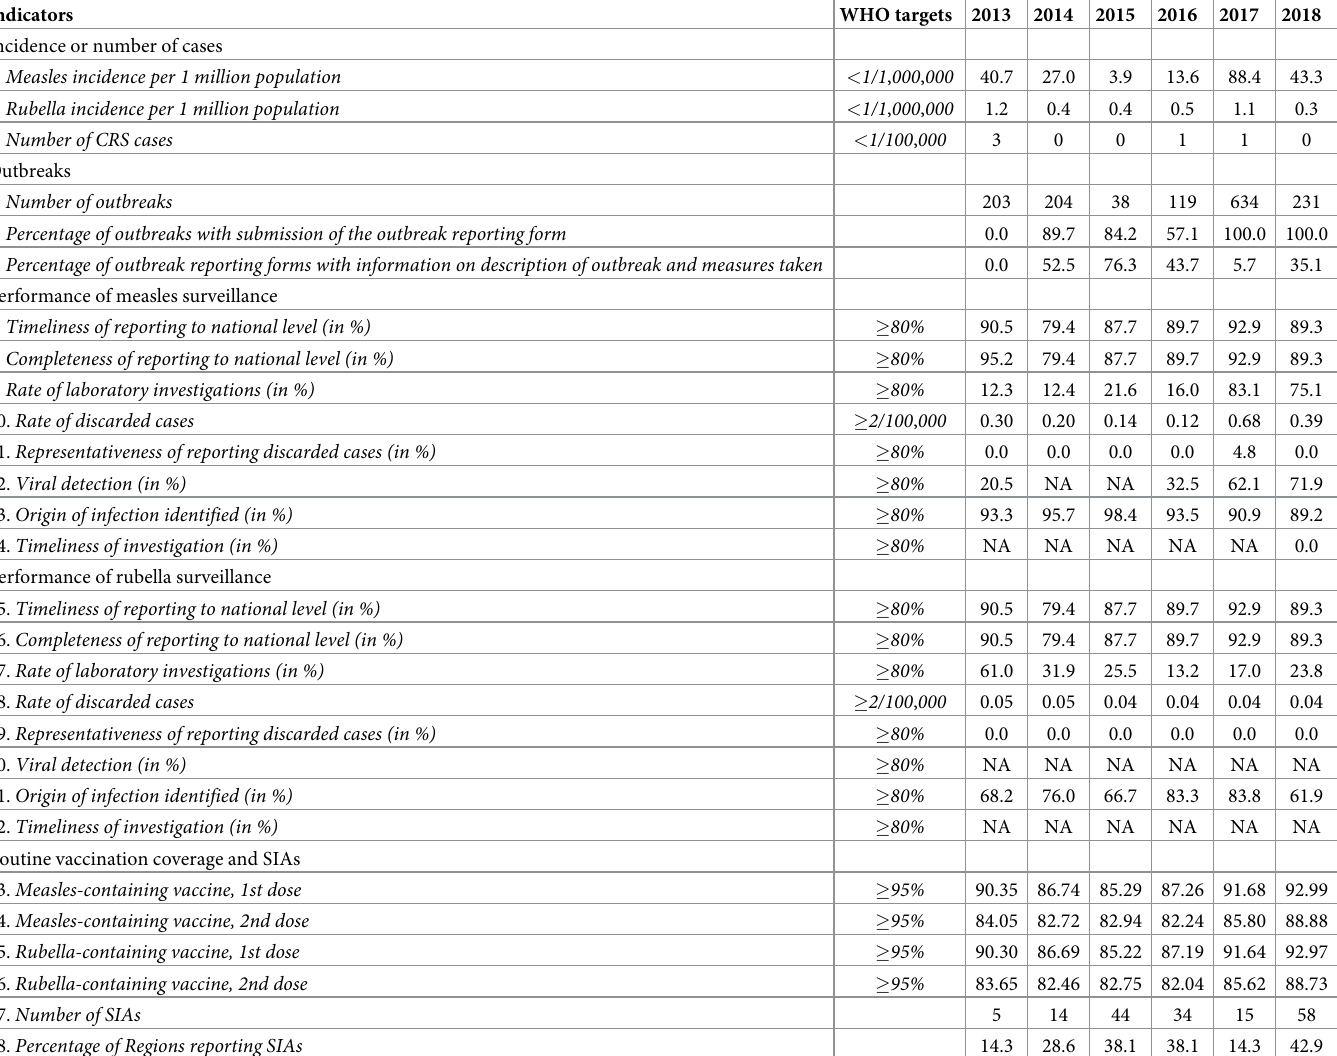
Table 2. Results of the analysis of data used in the national annual status updates, Italy